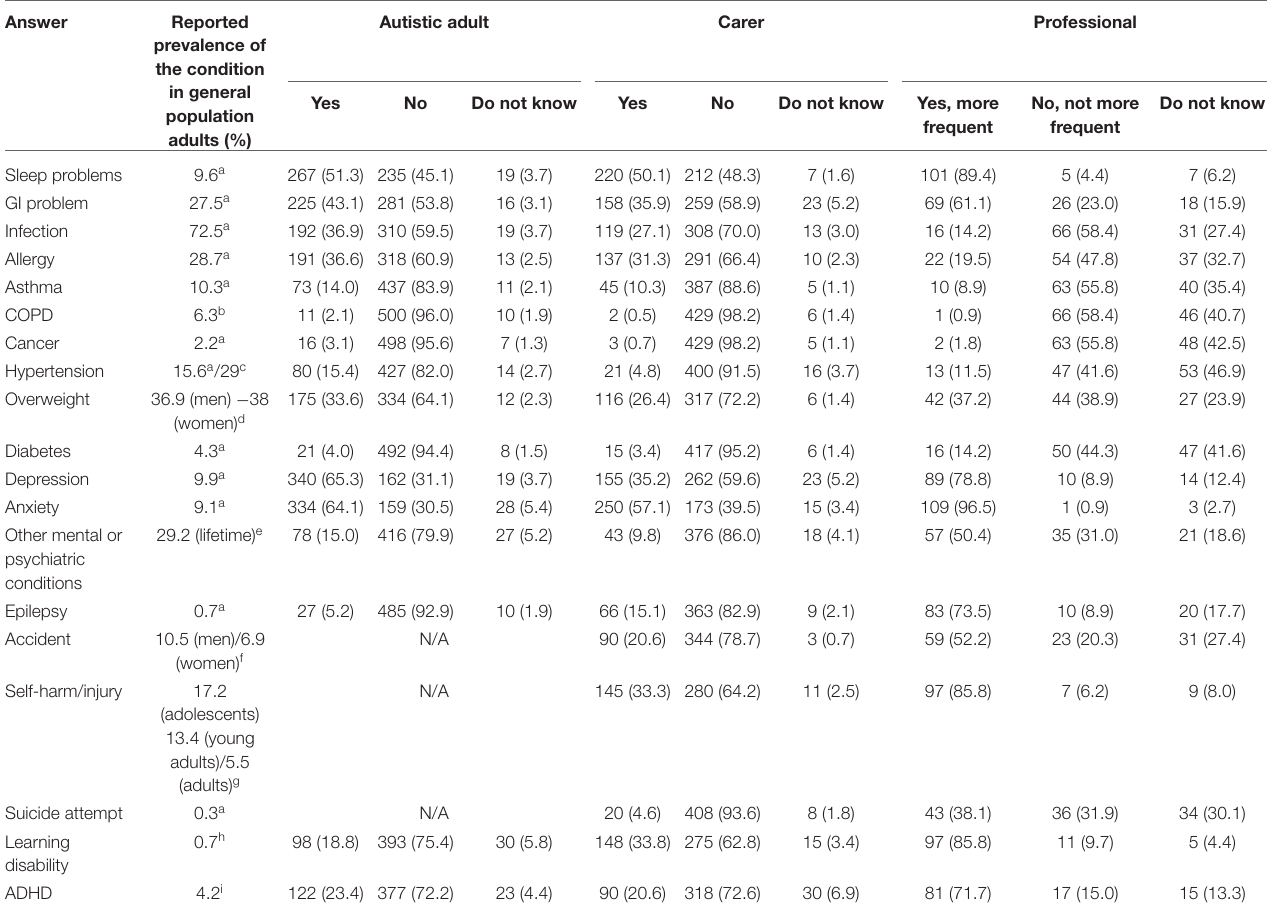
TABLE 1 | Health profile of autistic